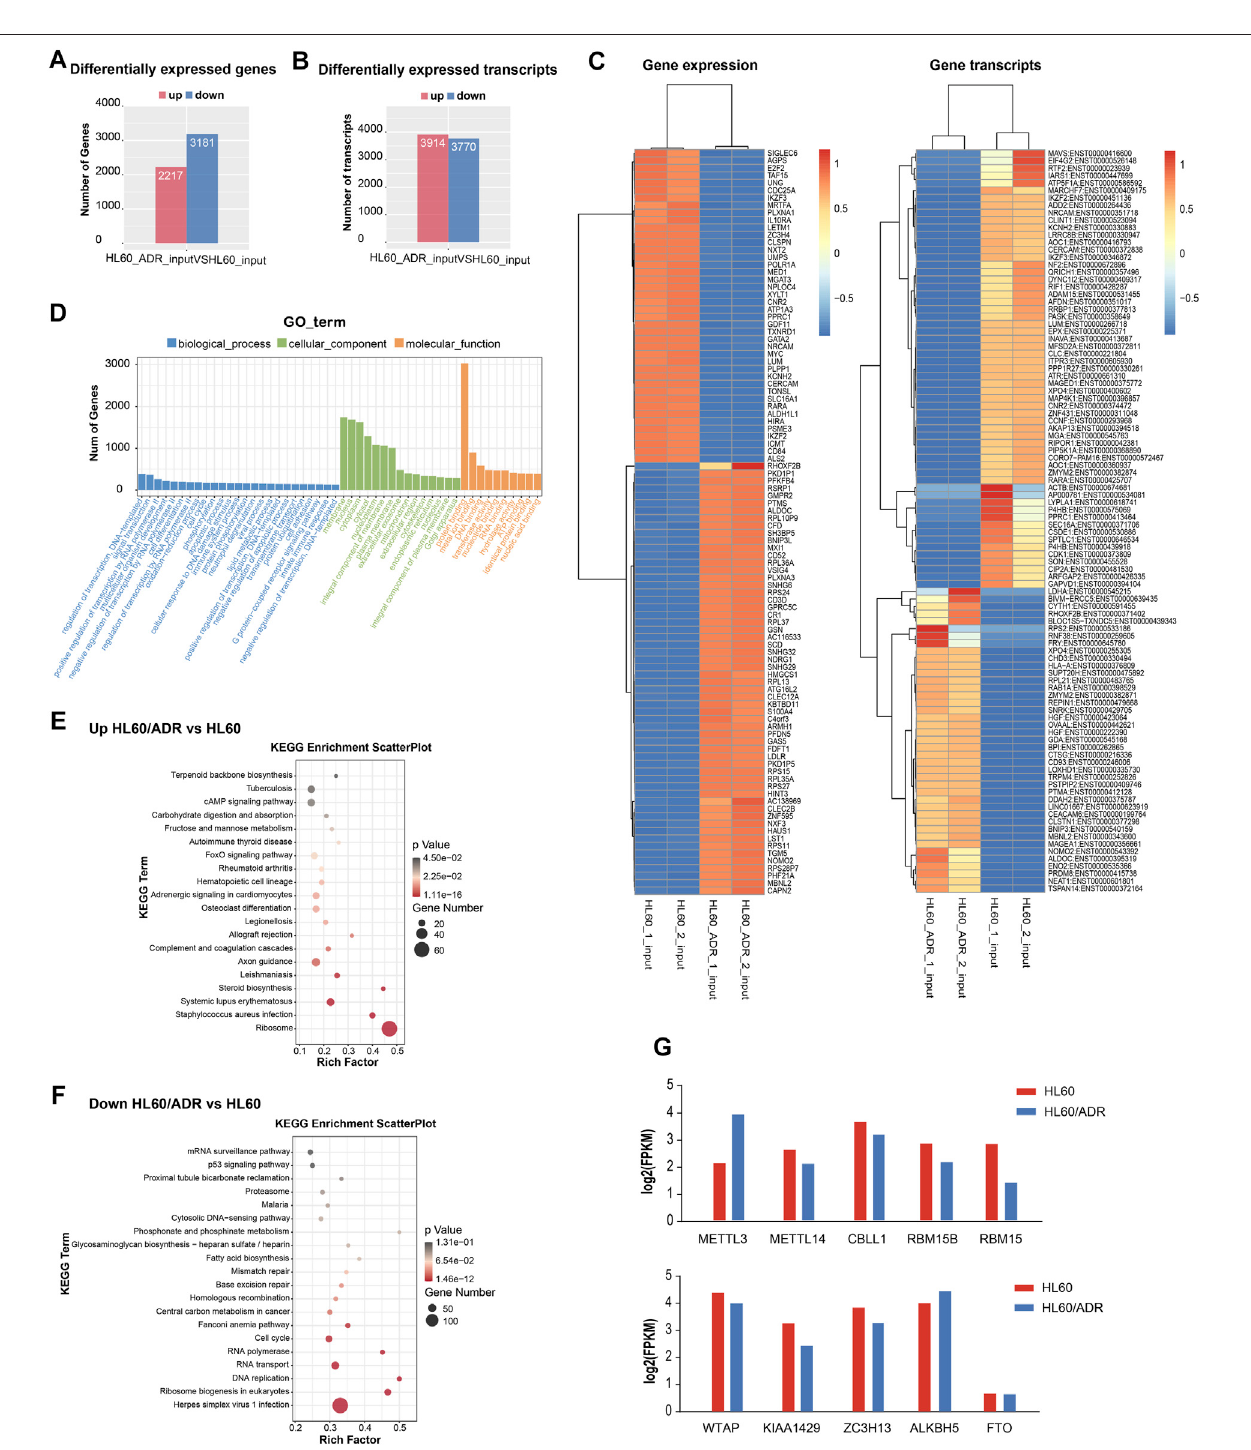
FIGURE 3 | Analysis of differentially expressed genes by RNA-seq. (A) Numbers of differentially expressed genes. (B) Numbers of differentially expressed transcripts. (C) Heatmapofdifferentiallyexpressedgenesandtranscripts. (D) GOanalysisincludedanalysisofthebiologicalprocess,cellularcomponent,andmolecular function. GO, Gene Ontology. (E,F) Pathway analysis of up-regulated genes (E) and down-regulated genes (F) . Rich factor, signi fi cant gene number/background gene number. KEGG, Kyoto Encyclopedia of Genes and Genomes. (G) Analysis of the expression level of ten m 6 A writers and erasers by RNA-seq in HL60 and